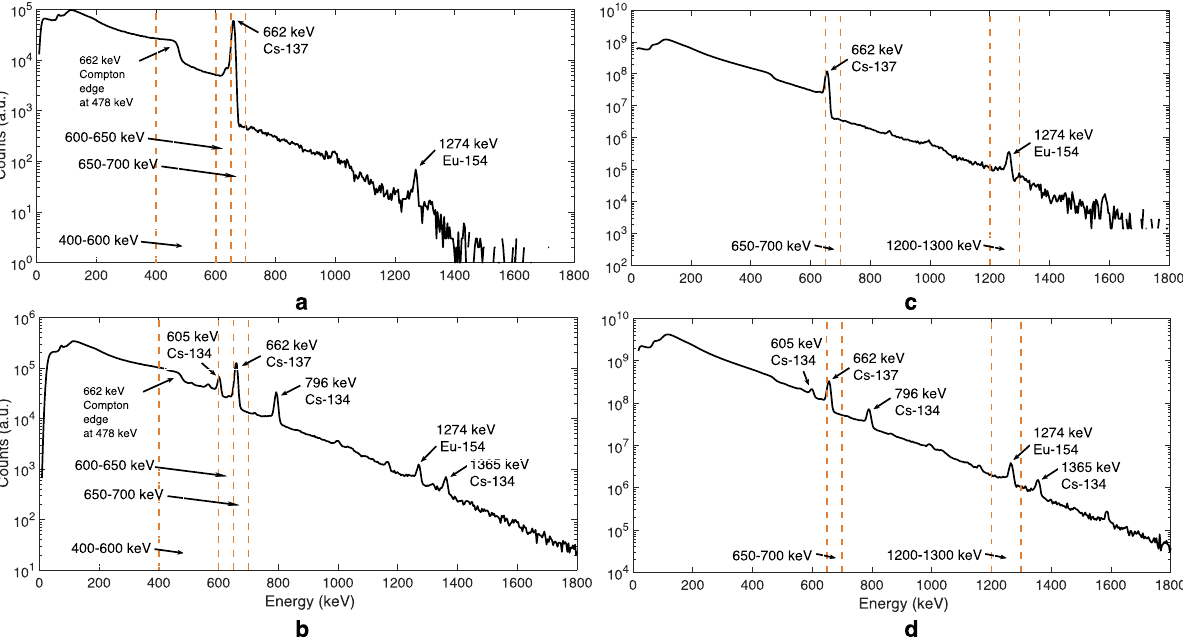
Figure 4. Gamma energy spectra and energy windows used (marked with orange dashed lines) for two BWR assemblies (left) and two VVER assemblies (right). ( a ) 8 × 8 − 1 (BU 18.6 GWd/tU, CT 37 a). ( b ) SVEA-